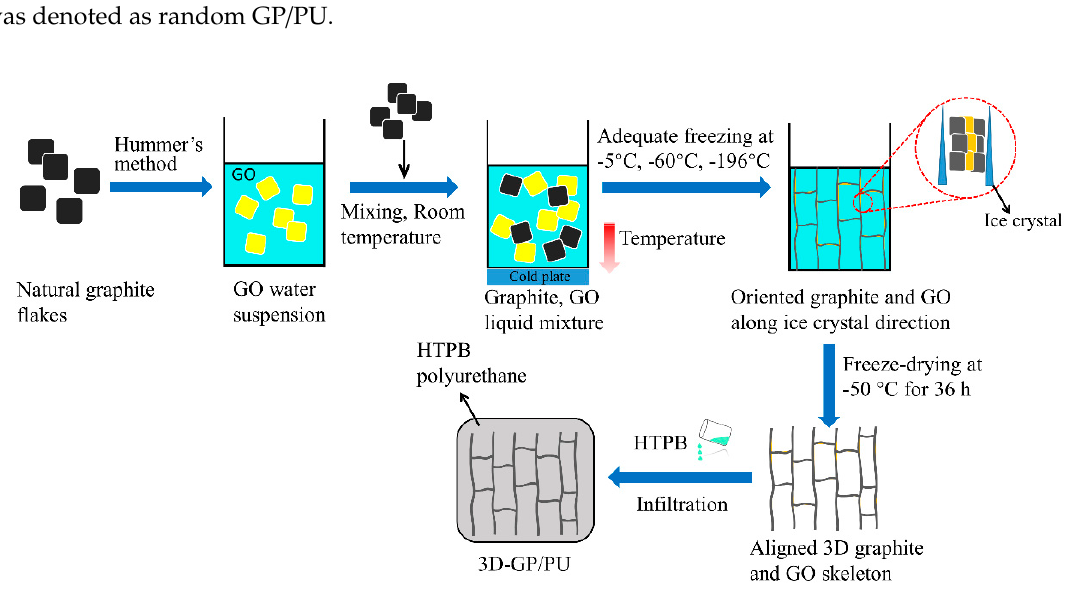
Figure 1. Schematic diagram of the fabrication process of 3D-GP/PU composites.